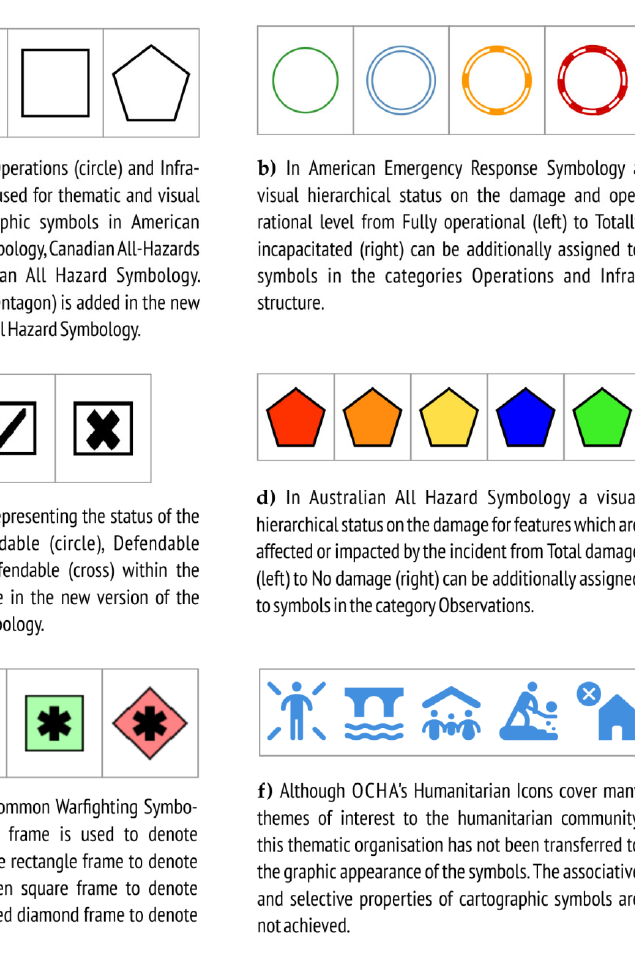
Figure 2. Taxonomy, visual and hierarchical organisation of cartographic symbols in the analysed symbol sets.